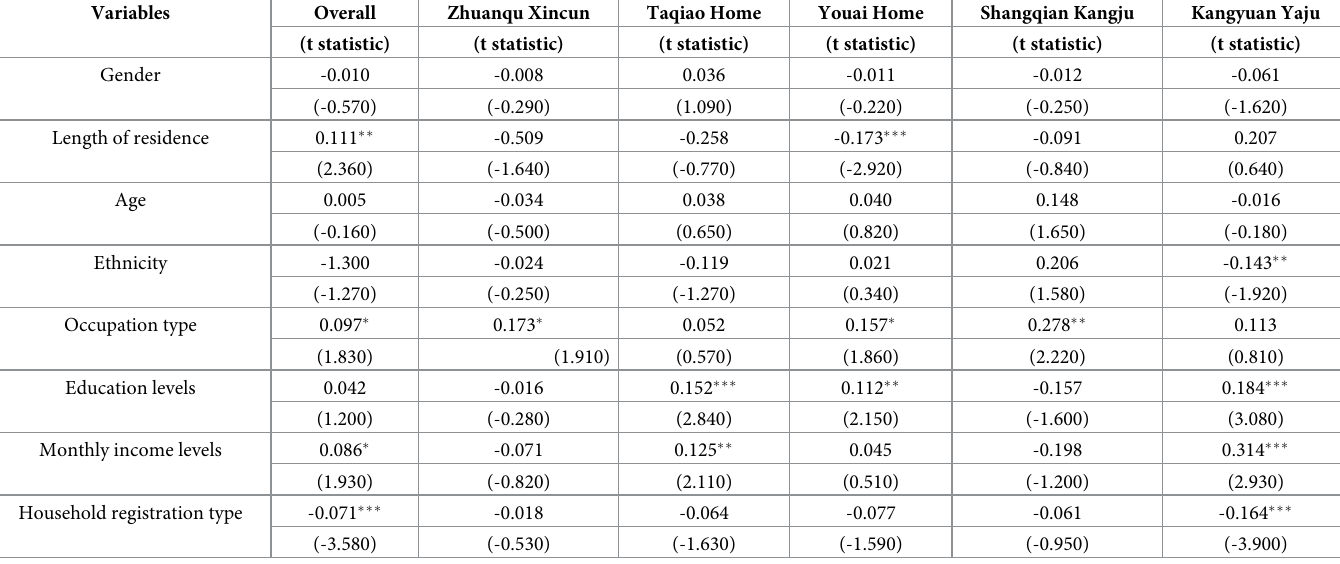
Table 6. Regression results of factors influencing the social space integration of ecological immigration.